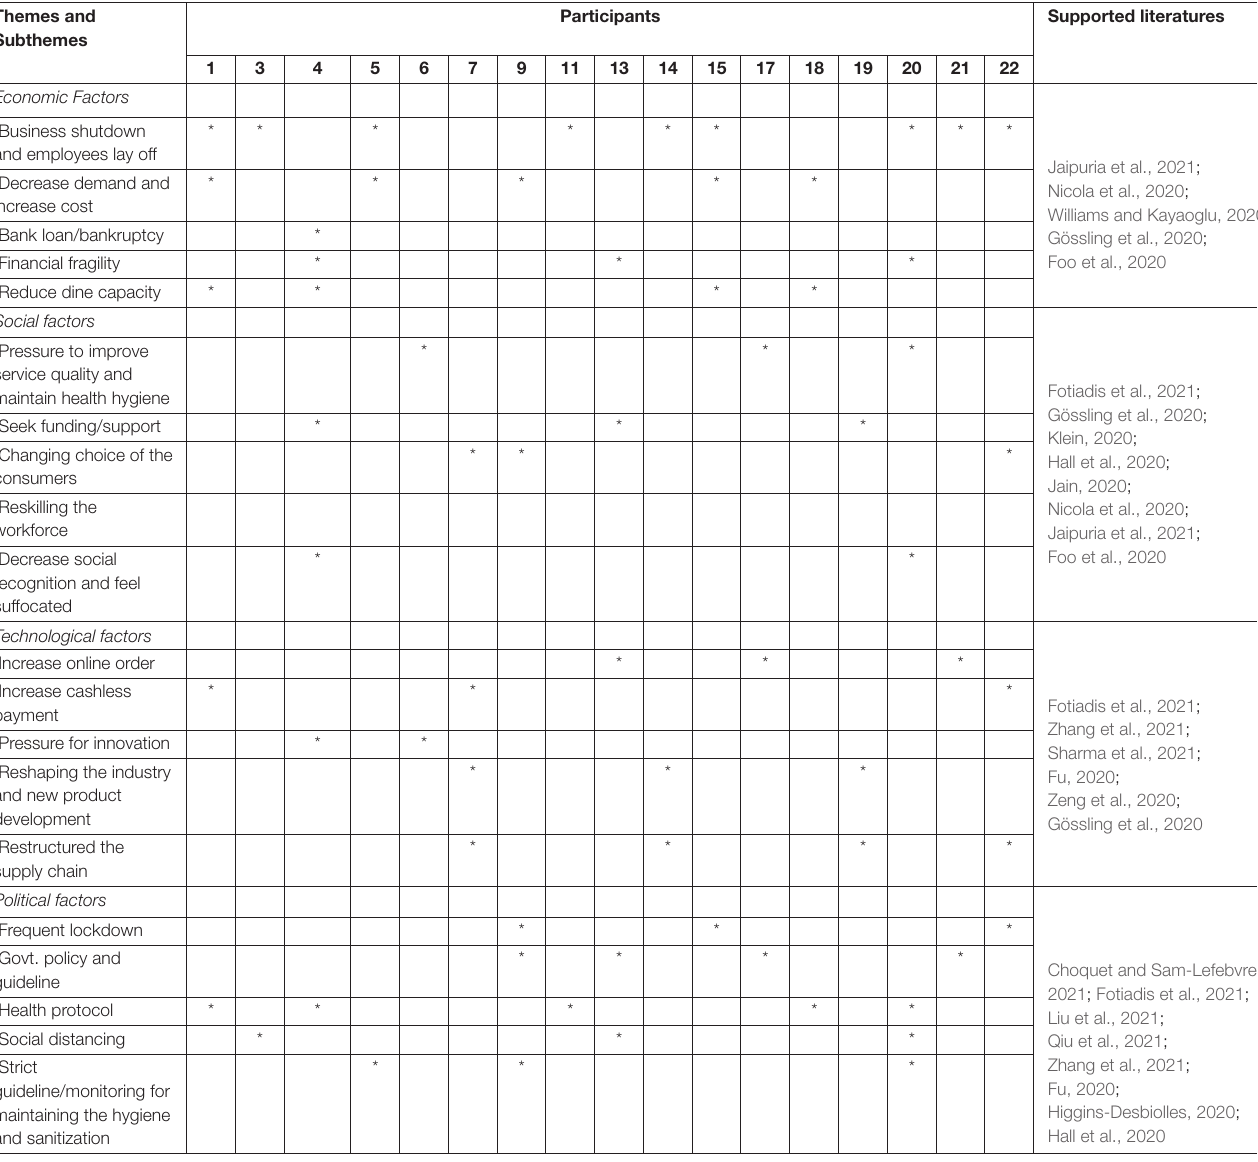
TABLE 1 | Factors and variables regarding the effects of COVID-19 on the restaurant